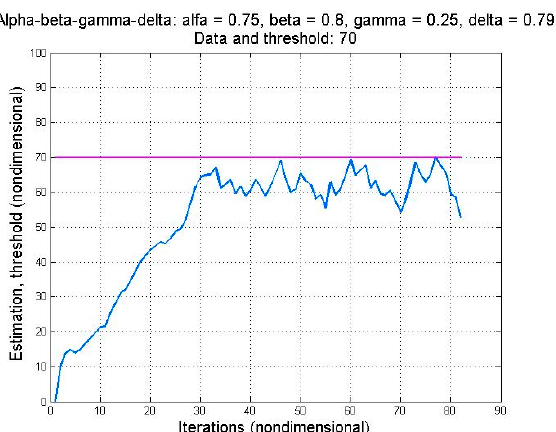
Figure 16. The α – β – γ – δ filter estimate exceeds the threshold value of 70 at iteration 77.